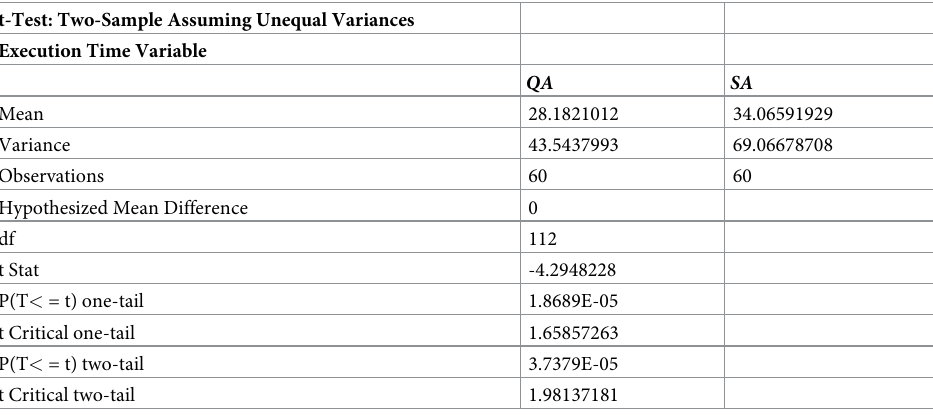
Table 17. T-test for n = 20 nodes and N = 60 trials—execution time variable. t-Test: Two-Sample Assuming Unequal